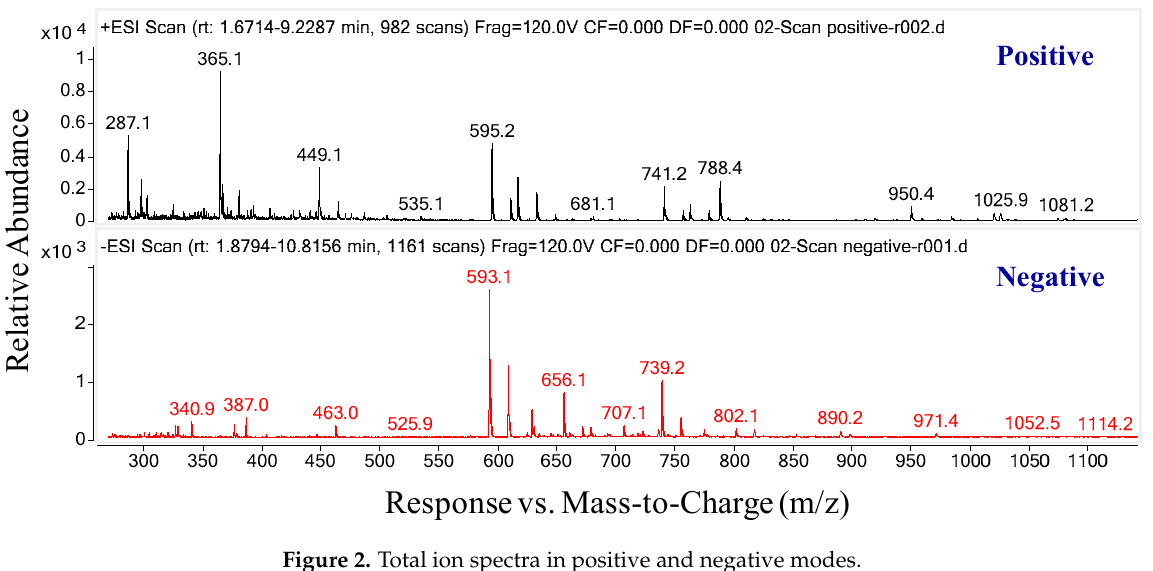
Table 2. Anthocyanin compounds identified in butterfly pea flower.